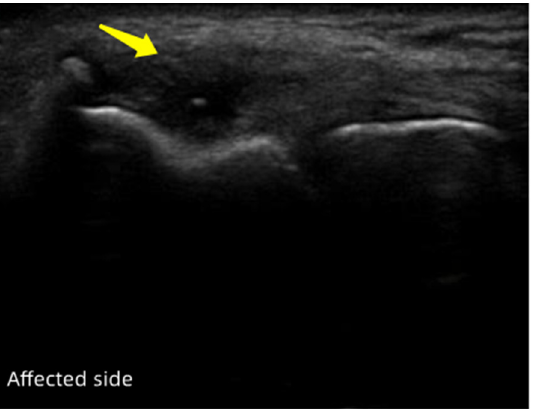
Figure 2. The ultrasound images of the lateral side of the right elbow affected with refractory lateral epicondylitis (case two) at the baseline. The arrow points to the damaged tendon.